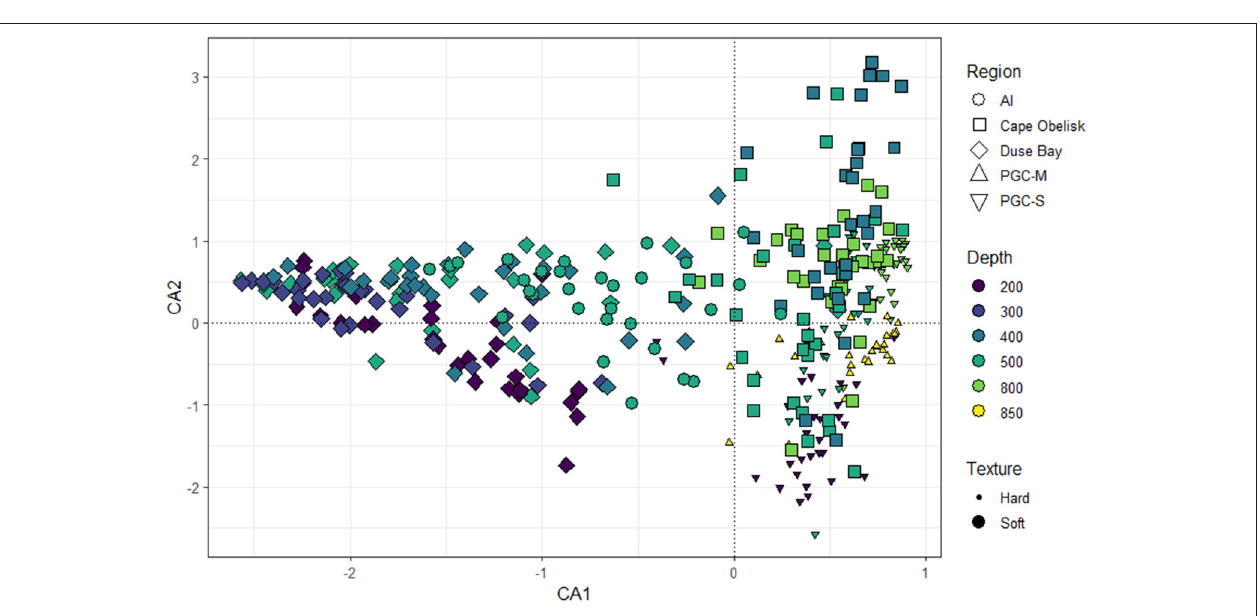
FIGURE 5 | Correspondence Analysis (CA) of benthic community structure according to region, depth, and substrate texture. CA1 and CA2 axis together explain 45% of observed